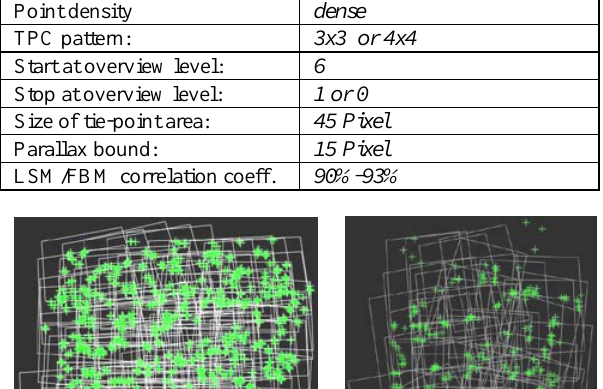
Table 6: MATCH-AT – Strategy and matching parameters